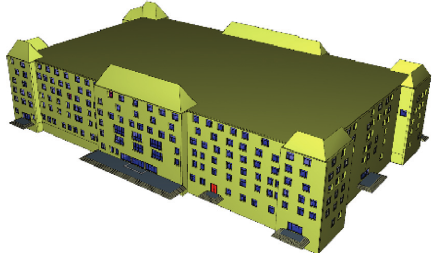
Figure 22: Fire model diagram in FDS.